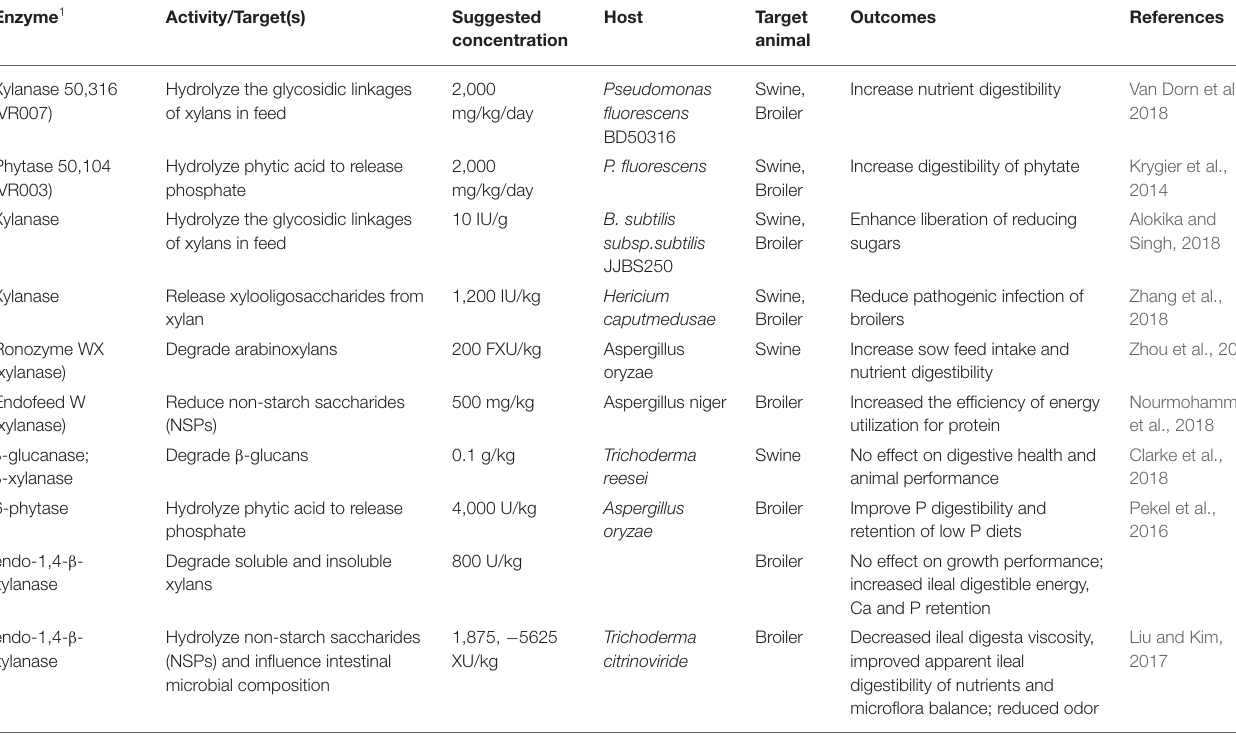
TABLE 3 | Examples of well-established natural and recombinant enzymes used in the feed industry. Enzyme